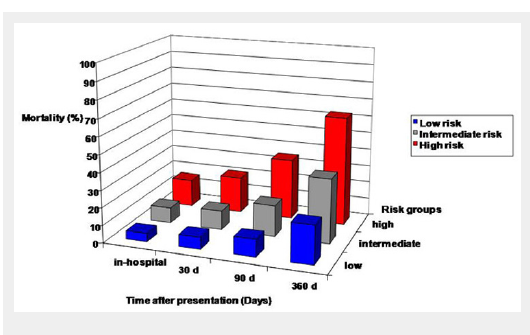
Risk stratification algorithm of AHF patients regarding 1-year mortality. Risk groups: high risk group (BUN >27.5 mg/dl and age >86 years), intermediate risk group (BUN >27.5 mg/dl and age ≤86 years) and low risk group (BUN ≤27.5 mg/dl); each node is based on available data from patients presenting to the ED.